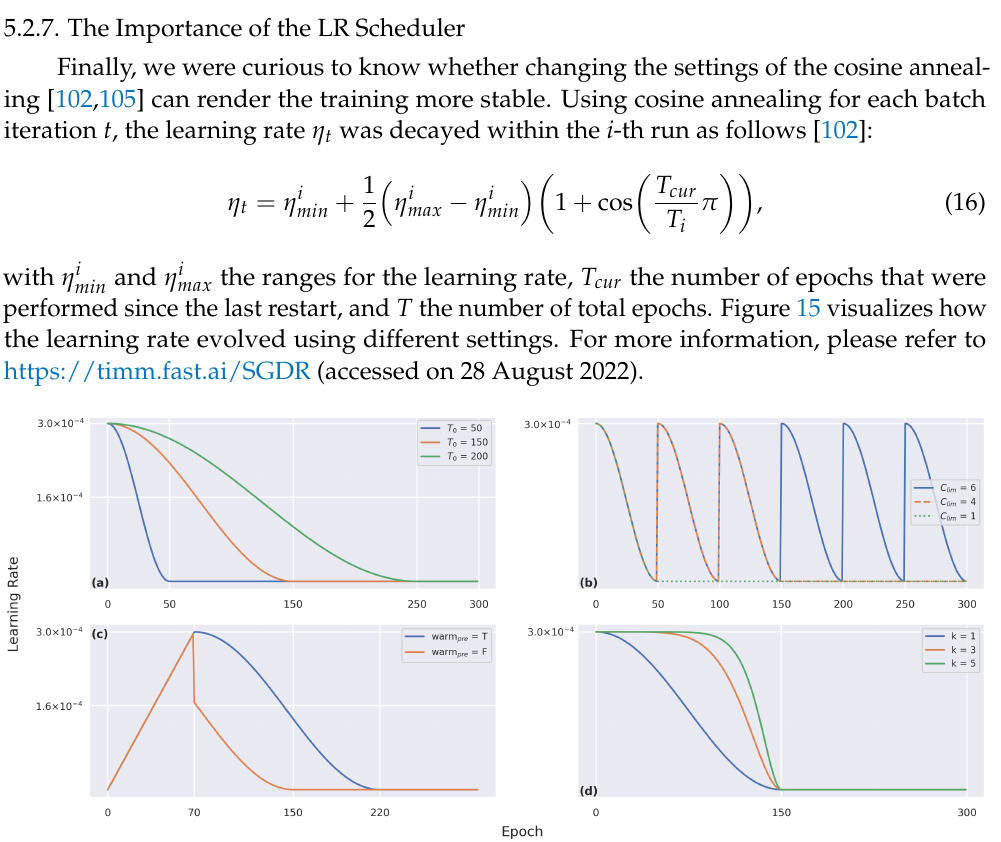
Figure 14. The mAP in % per epoch when training VOLO-D3 using the three losses, BNNeck with different learning rates: 0.015000 (orange), 0.0150001 (blue), 0.015001 (green), and 0.015010 (red).